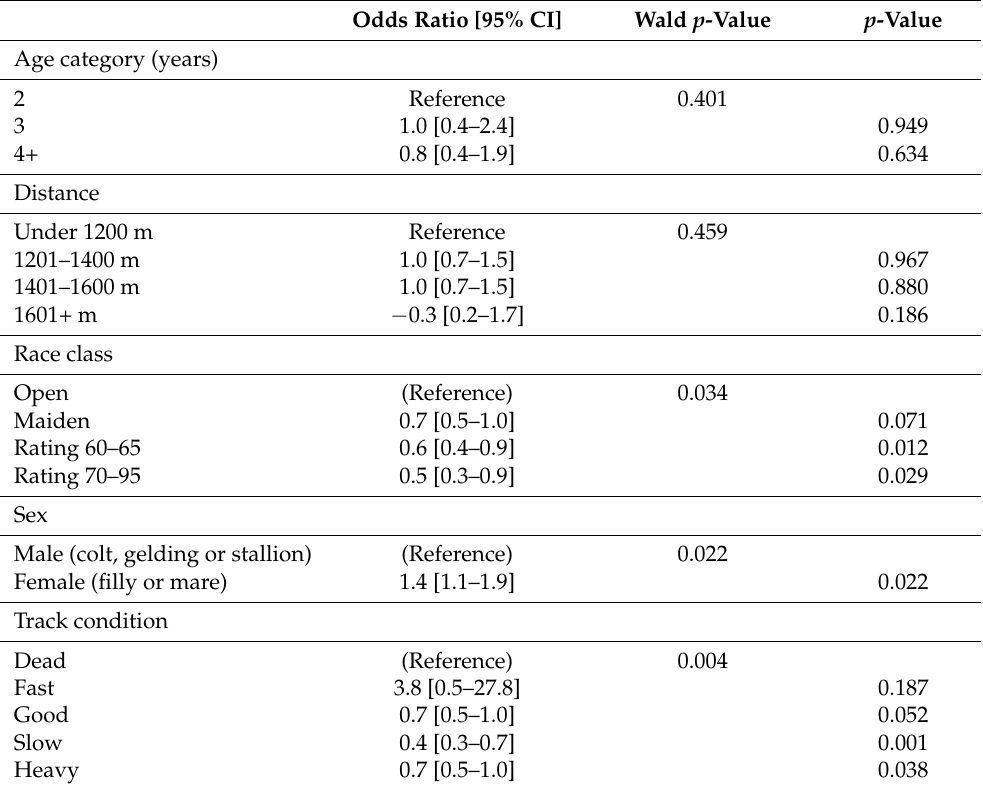
Table 2. Univariable odds ratios and 95% confidence of an incident occurring with the effects of age, distance, race class, sex and track condition. Odds Ratio [95% CI] Wald p -Value p